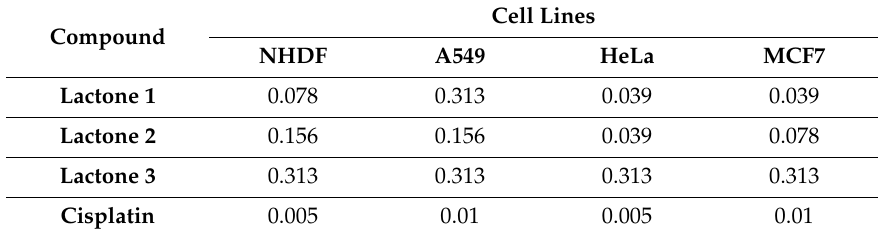
Table 2. The minimal toxic concentration (MTC) of lactones 1 – 3 against selected cell lines [mg / mL]. Compound